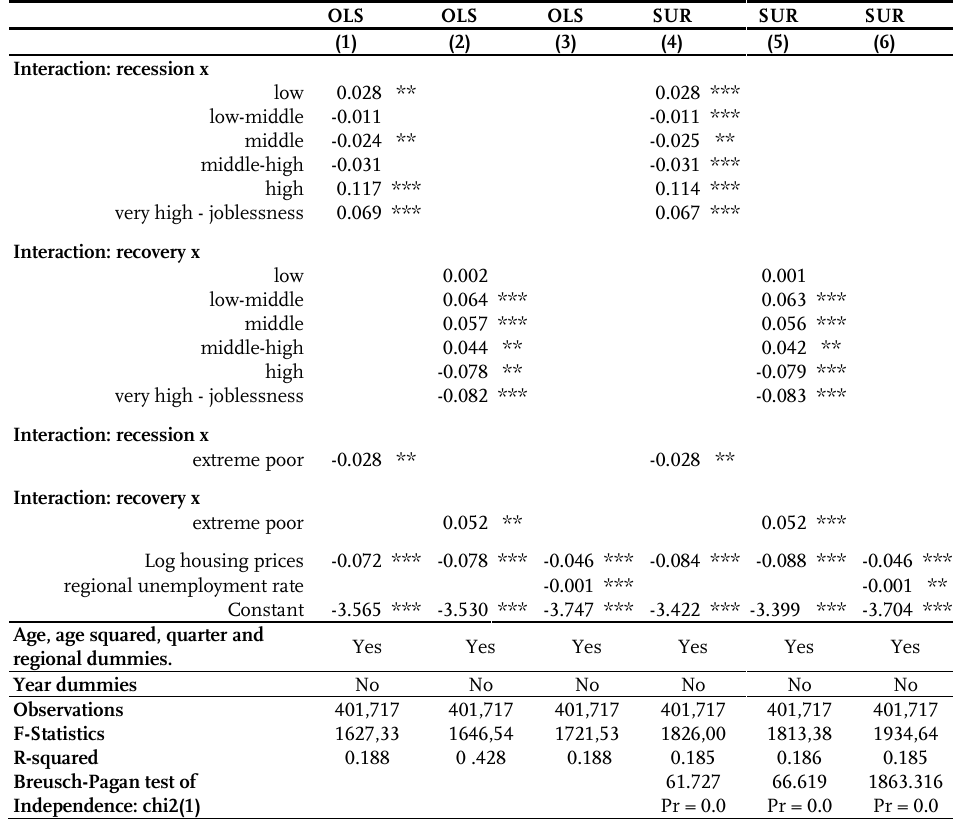
OLS and Seemingly Unrelated Regression results on emancipation for females between 26-34 years of age (1=cohabiting), 2005-2017